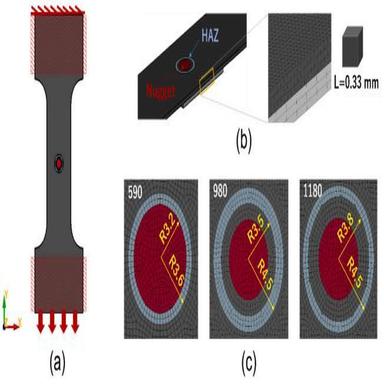
FEM uniaxial tensile model. (a) Boundary conditions, (b) division of regions and element size, (c) radius and locations of fusion zone for different DP steels.